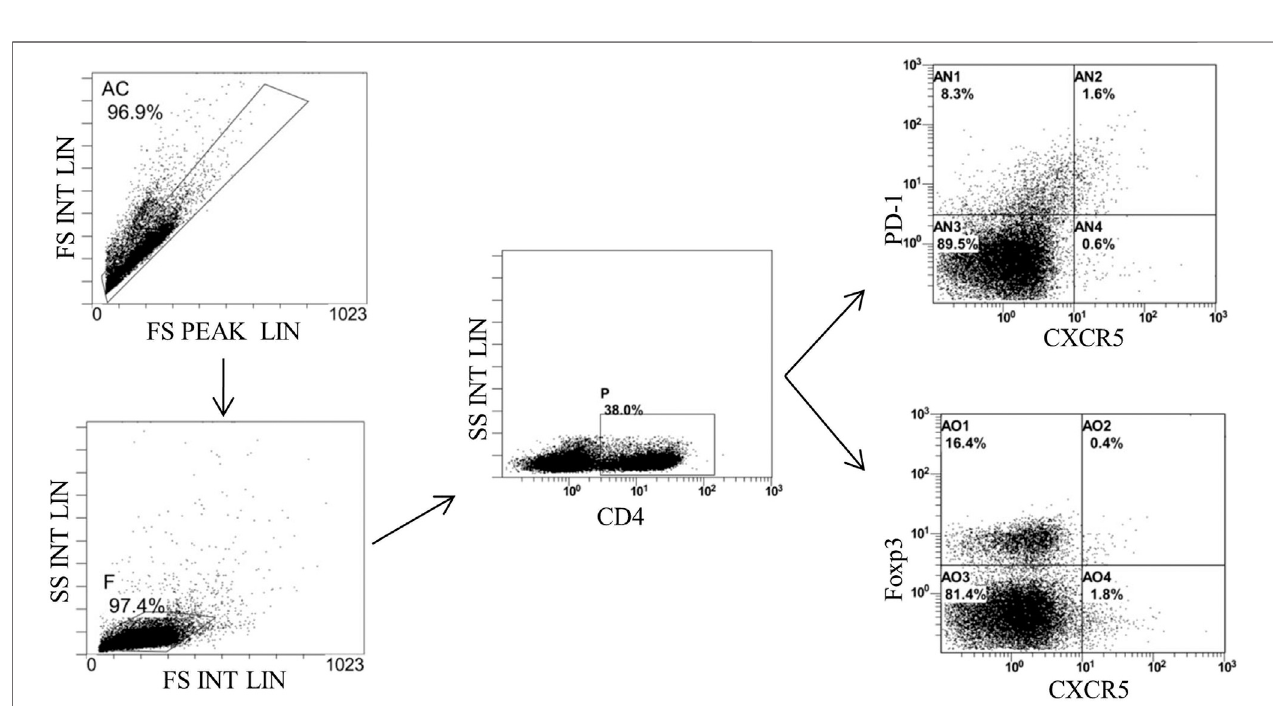
FIGURE 9 | Gating strategy of Tfh and Tfr in the MLNs of mice detected by fl ow cytometry. Gate AC: nonadherent cells; gate F: lymphocytes; gate P: CD4 + cells; gate AN2: CD4 + CXCR5 + PD-1* T th in CD4 + cells; gate A02: CD4 + CXCR5 + Foxp3 + Tfr in CD4 + cells; and MLNs: mesenteric lymph nodes.